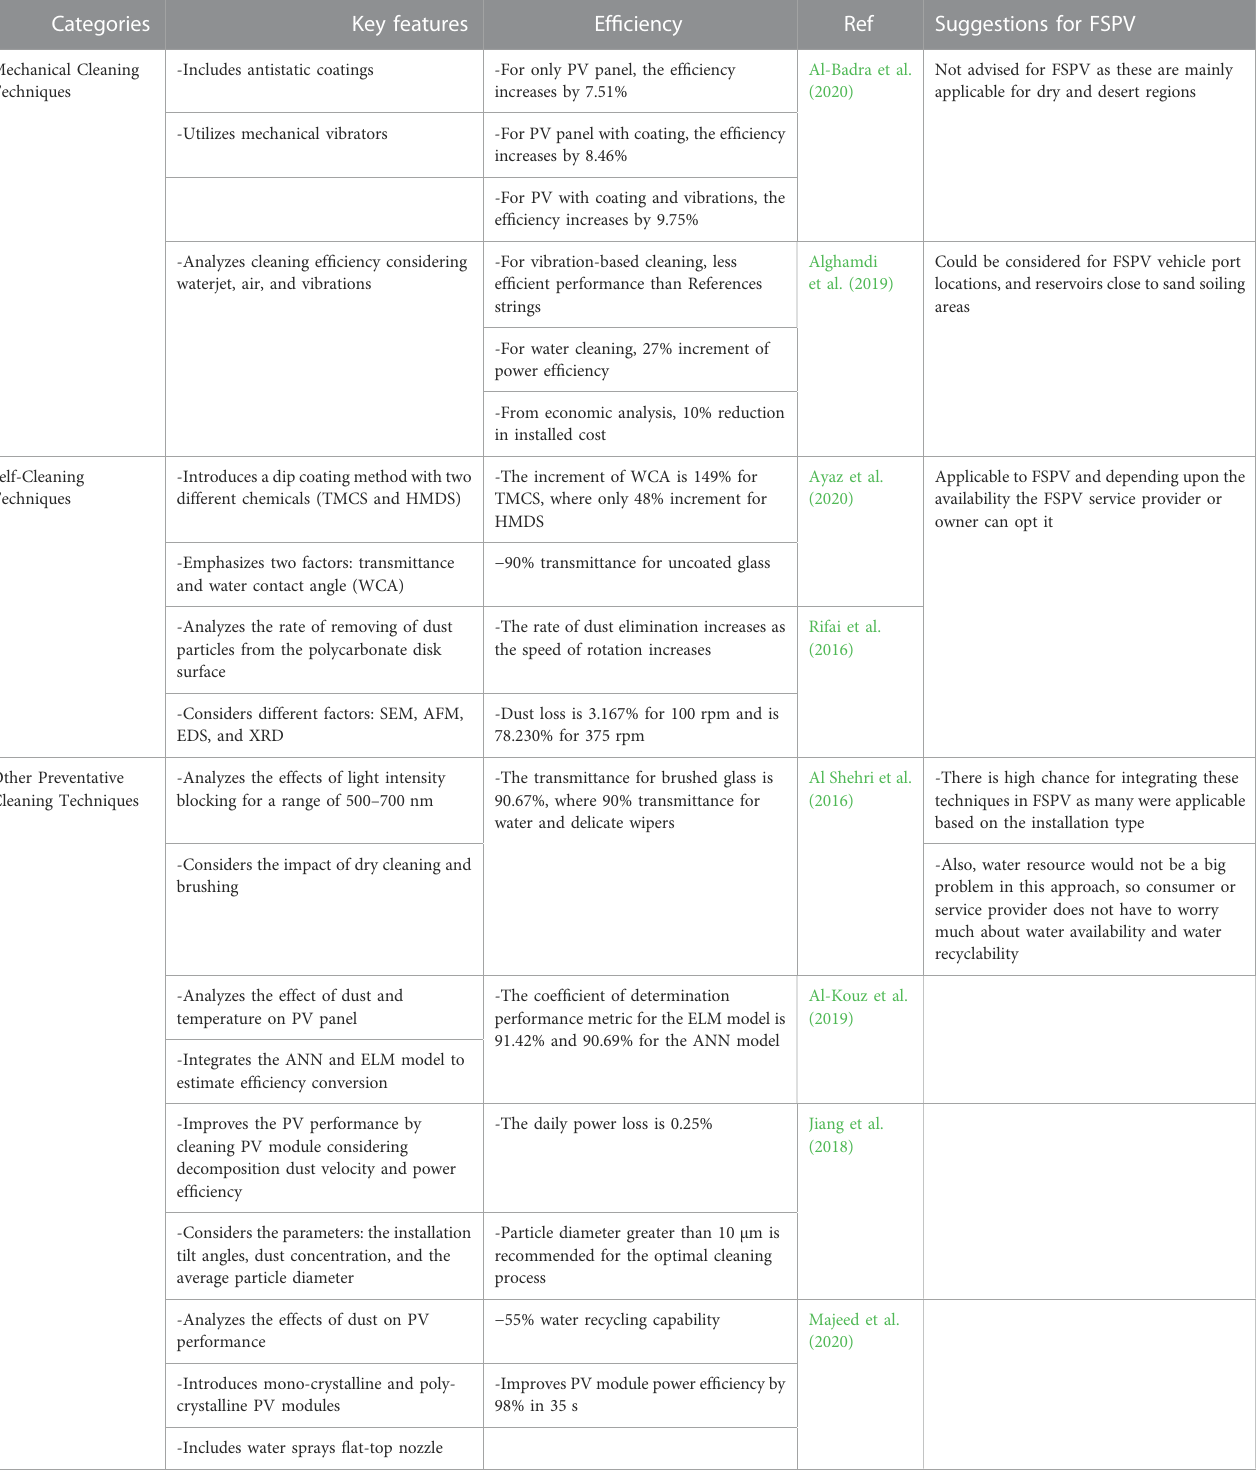
TABLE 5 Summary of different cleaning techniques highlighting their key features and ef fi ciency improvements along with applicability to FSPV.